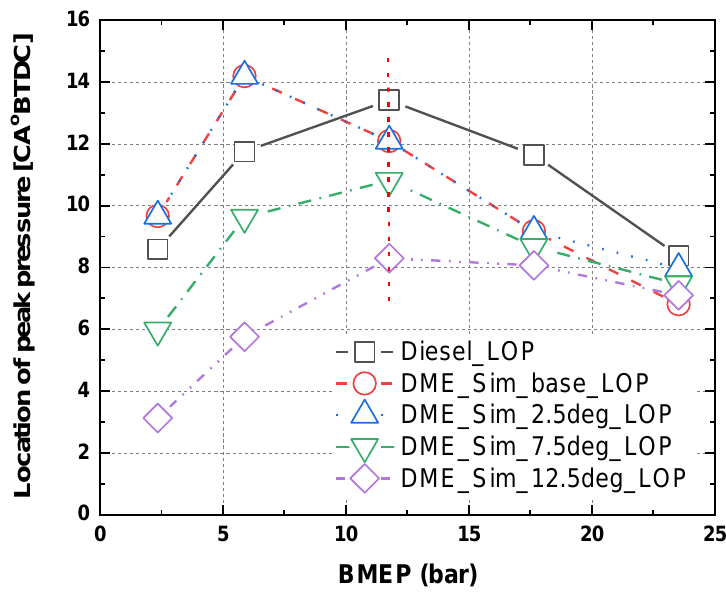
Figure 5. Characteristics of the locations of the pressure peaks versus start of injection timing for marine diesel fuel and DME fuel.